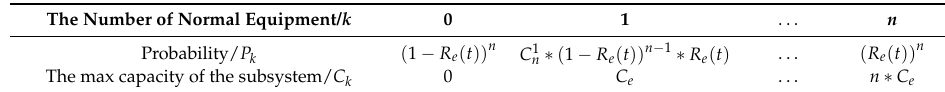
Table 2. Capacity parameters of the